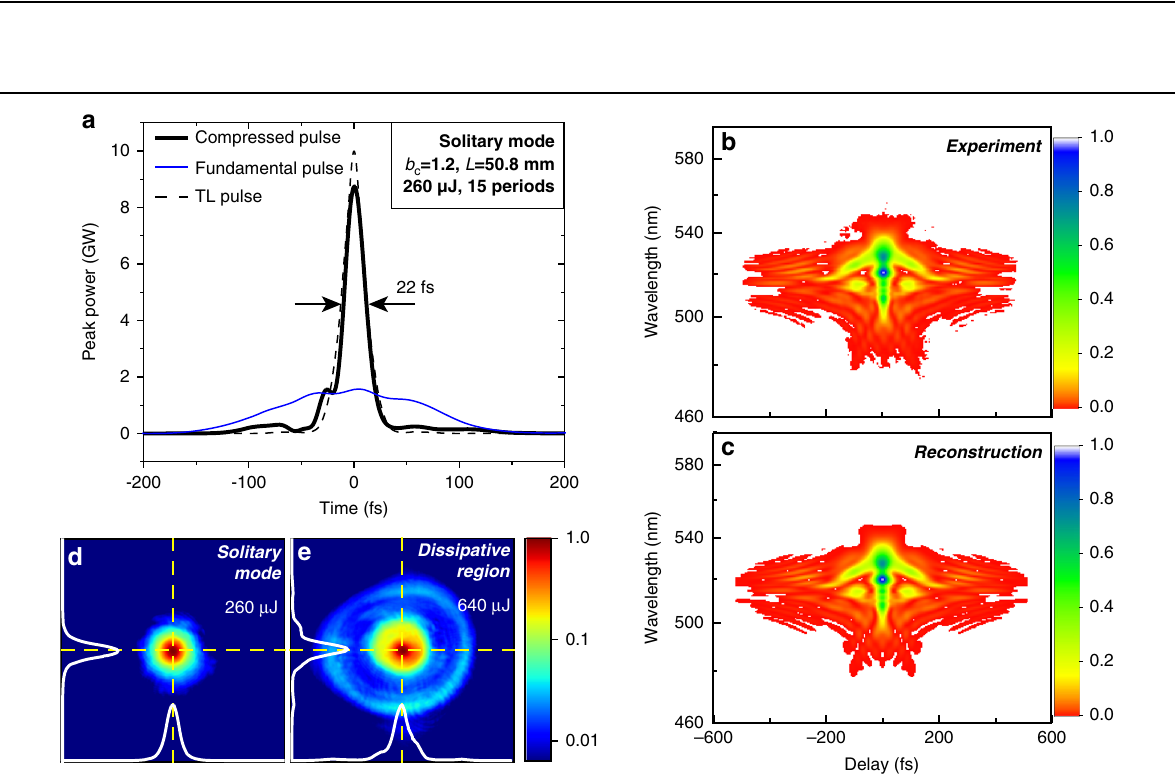
Fig. 3 High-ef fi ciency pulse compression under the solitary modes. a The temporal intensity pro fi les of the compressed pulse (solid black) and the incident pulse (solid blue). The dashed black line is the TL pulse. b , c The measured and reconstructed FROG traces. d The spatial mode of the output beam at resonance ( E in = 260 µJ). The intensity is plotted on a log-scale to highlight the conical emission. The white lines display the x and y transverse pro fi les of the beam. e Same as ( d ). but with E in = 640 µJ in the dissipative